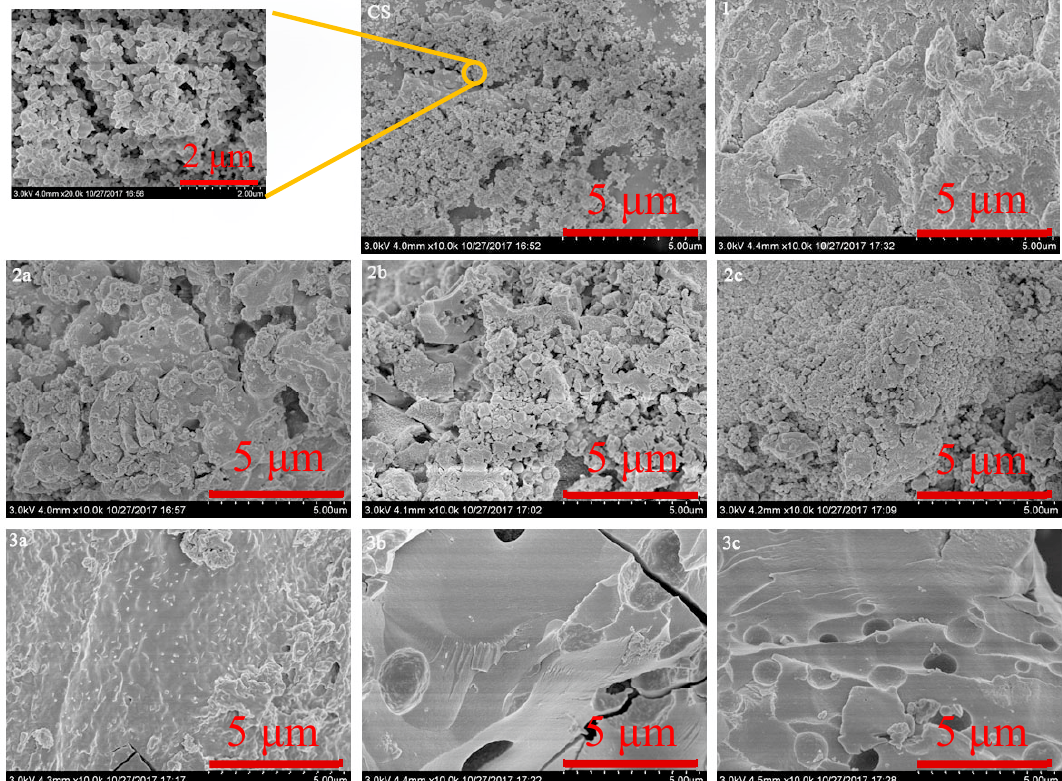
Figure 3. SEM images of chitosan and chitosan derivatives.